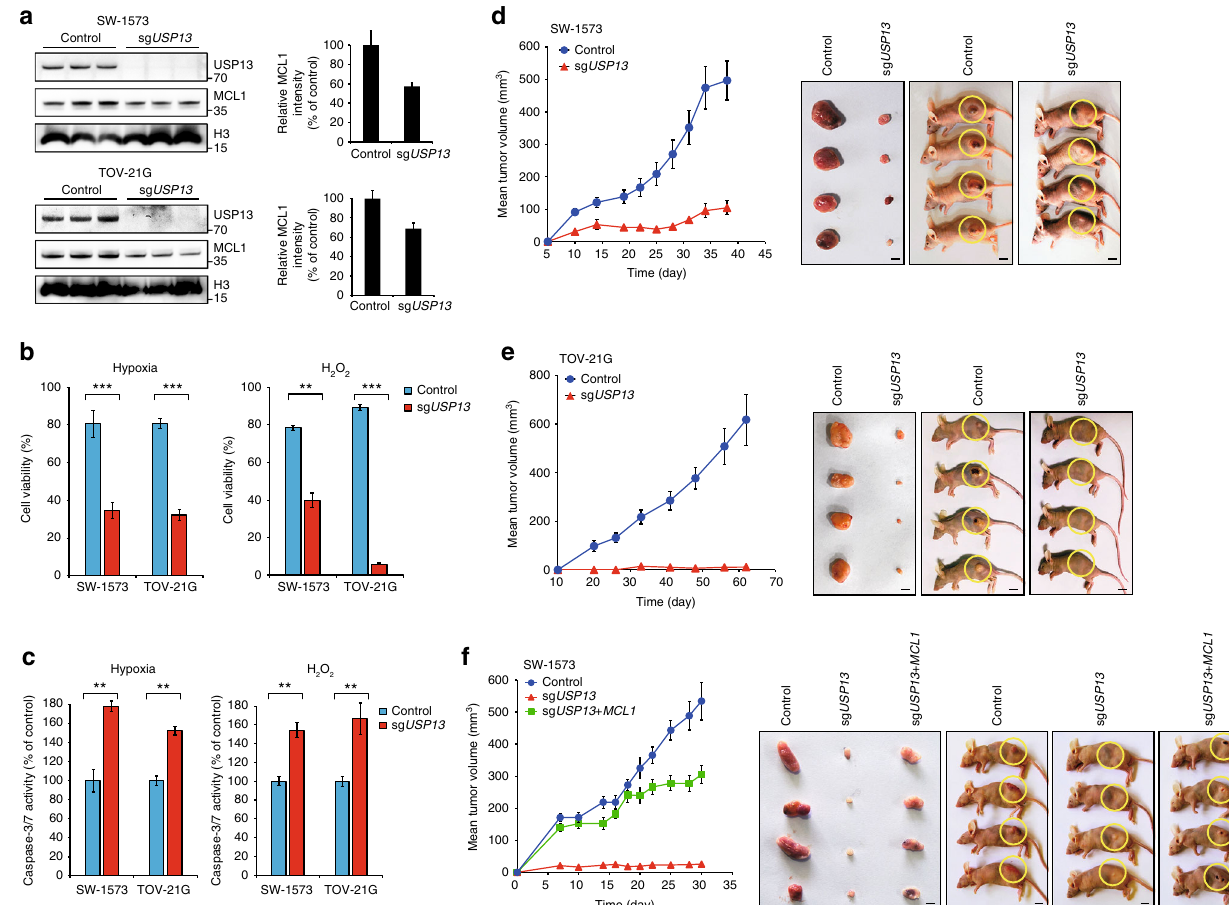
Fig. 5 USP13 genetic deletion suppresses tumor growth. a USP13 depletion in SW-1573 and TOV-21G cells using the CRISPR/Cas9 system. The endogenous USP13 and MCL1 protein levels were measured by western blotting. b Cell viability upon USP13 depletion was measured using Cell Counting Kit-8 under hypoxic or oxidative stresses, and error bars indicated standard deviation (each condition contained three biological replicates). c Cell apoptosis upon USP13 depletion was measured using Caspase-Glo 3/7 Assay under hypoxic or oxidative stresses, and error bars indicated standard deviation (each condition contained three biological replicates). d Tumor growth curves and representative tumor images were shown for USP13 -depleted SW-1573 cells subcutaneously implanted into nude mice (scale bar, 10 mm). Error bars indicated standard deviation (10 mice per group). e Tumor growth curves and representative tumor images were shown for USP13 -depleted TOV-21G cells subcutaneously implanted into nude mice (scale bar = 10 mm). Error bars indicated standard deviation (10 mice per group). f Tumor growth curves and representative tumor images were shown for USP13 -depleted/ MCL1 - overexpressed SW-1573 cells subcutaneously implanted into nude mice (scale bar, 10 mm). Error bars indicated standard deviation (10 mice per